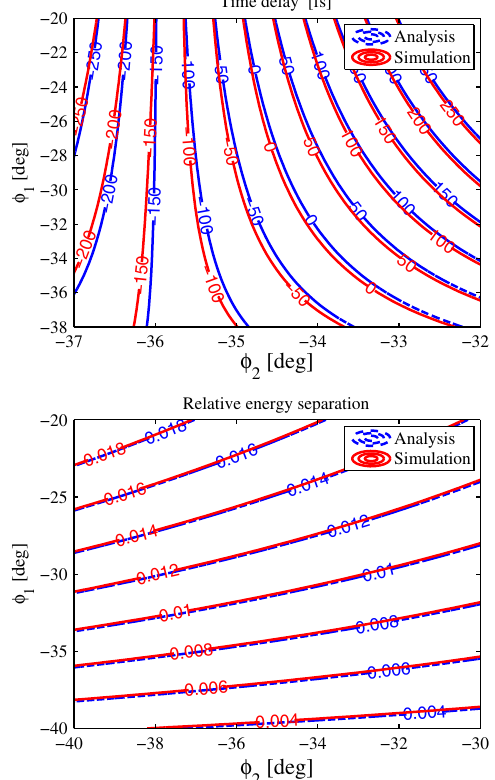
FIG. 2. The contours of the time delay (up) and relative energy separation (down) of the two bunches. The blue dashed line is the analysis results of Eqs. (3) and (4) and the red line is the simulation results of L I T RACK without the linac wakefields. The amplitude of L1X in this simulation is set to